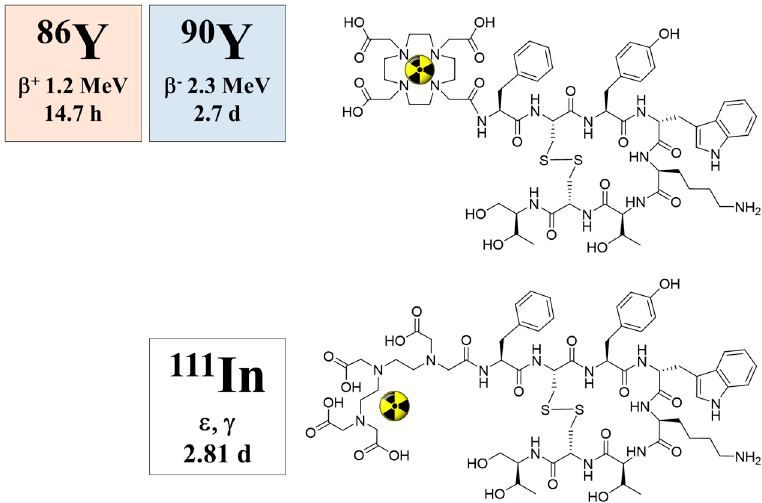
Figure 14. Chemical structures of DOTATOC (for labelling with 86 Y and 90 Y) and the DTPA-conjugated octreotide derivative pentreotide (for labelling with 111 In).